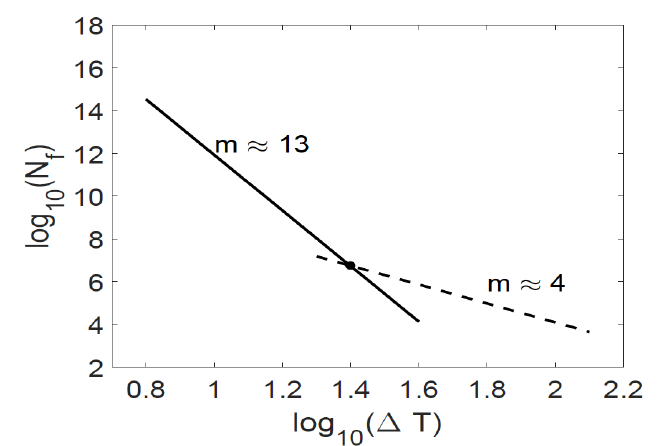
Figure 13. Number of cycles to failure are presented as a function of temperature cycling for a constant mean junction